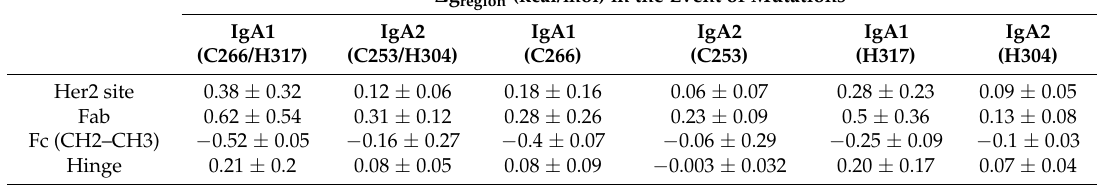
Table 3. Allosteric free energy ( ∆ g region ) estimated in mutation events (accumulative or single mutations) using different conformations of the wild-type variants IgA1 and IgA2. ∆ g region (kcal/mol) in the Event of